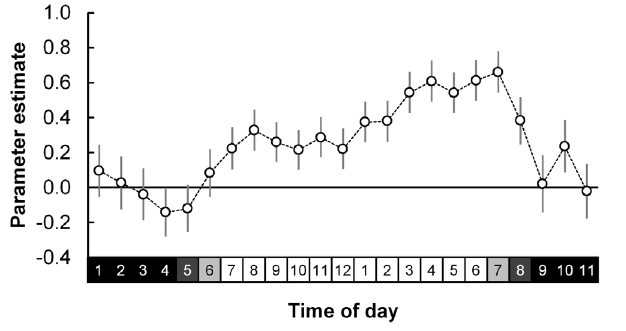
Fig. 4. Parameter estimates of nest arrival time as a predictor of nest attendance duration for breeding Cape gannets at Bird Island, Algoa Bay. Time is modelled as 24 one-hour bins. Parameter estimates are derived from Model N2, Tables 1 and 2. Standard error bars as well as day (light squares) and night (dark squares) are indicated.